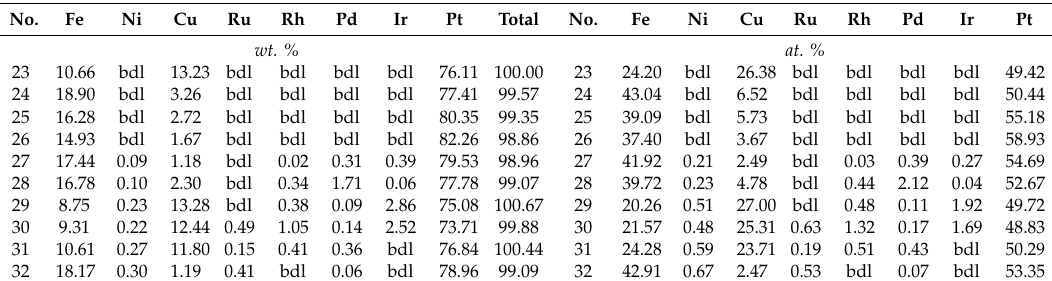
Figure 7. Composition (at. %) of isoferroplatinum (1), ferroan platinum (2) and tetraferroplatinum- tulameenite (3) from placers associated with the Svetloborsky massif and lode chromite-platinum ore zones. N—number of isoferroplatinum/ferroan platinum/tetraferroplatinum-tulameenite. The grey Pentagrams are stoichiometric formulae.